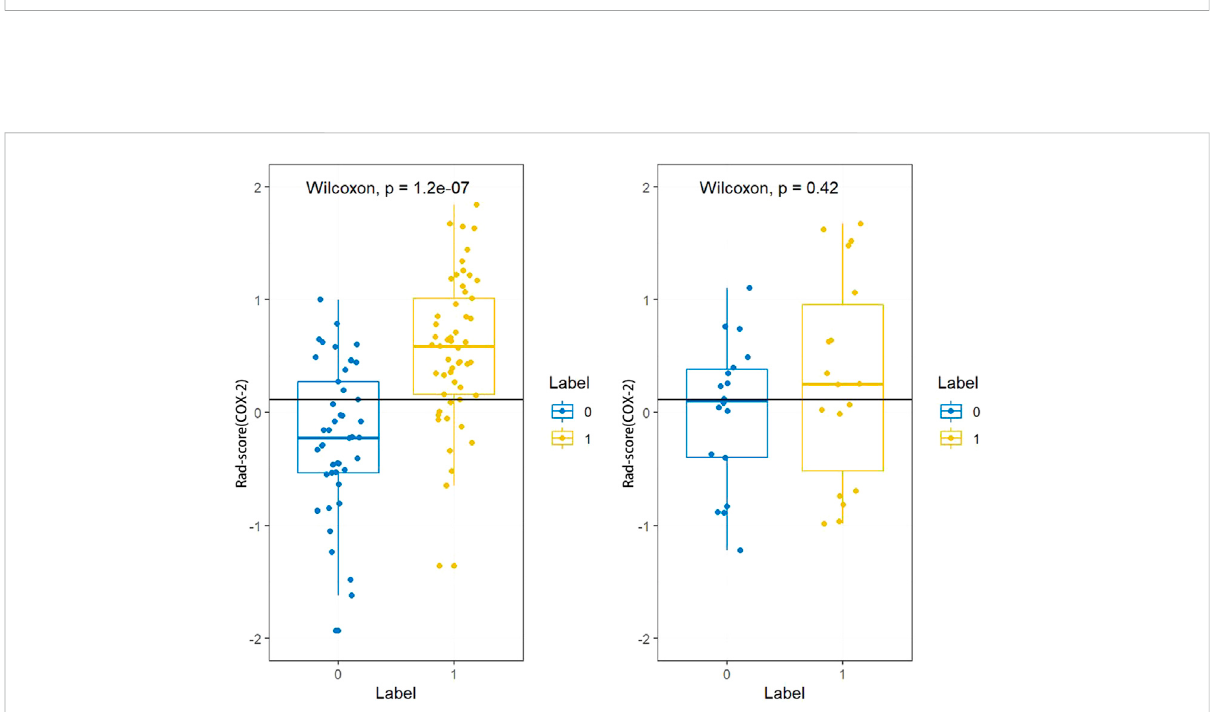
FIGURE 8 Rad-score (COX-2) distribution difference between COX-2 low expression subgroup and high expression subgroup in the training dataset and testing dataset. Rad-score (COX-2) of patients with high expression of COX-2 was higher than that with low expression of COX-2 in the training dataset( p < 0.001).Inthetestingdataset,therewasnosigni fi cantdifferenceinRad-score(COX-2)betweenpatientswithhighCOX-2expressionand patients with low COX-2 expression ( p <